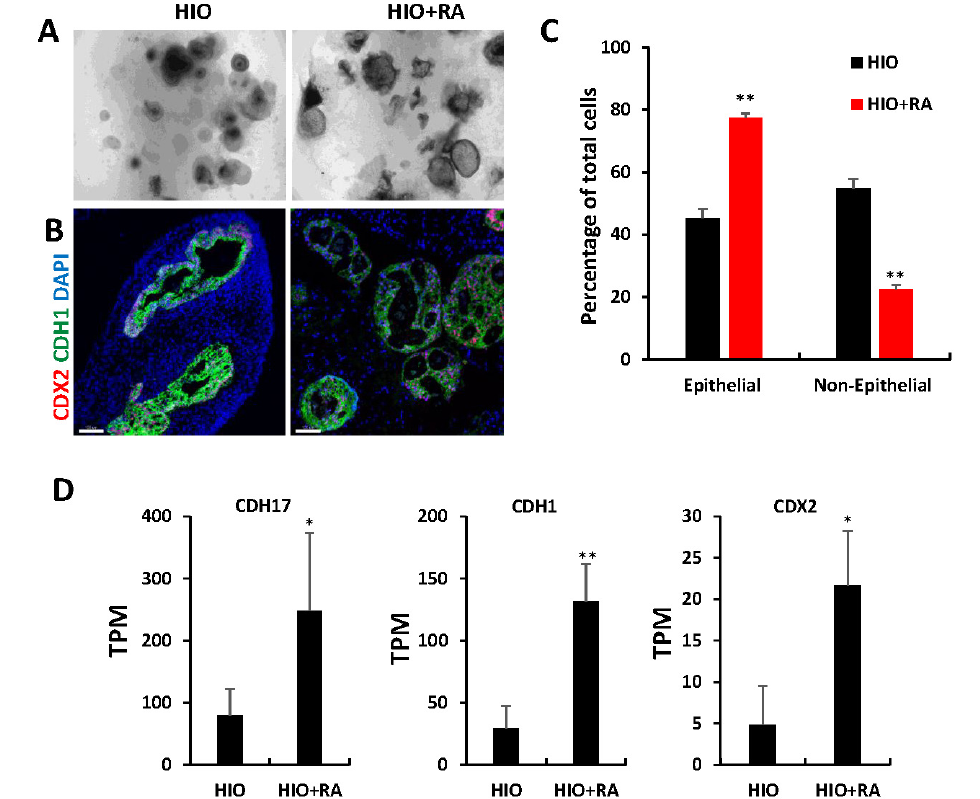
Figure 4. Retinoic acid promotes epithelial growth. ( A ) Light microscopy images of HIOs and HIOs + RA. ( B ) Immunofluorescence staining of 35-day-old organoids from (HIOs and HIOs + RA) for CDX2 (red), CDH1 (green) and counterstained with DAPI. ( C ) Quantification of the percentage of epithelial and non-epithelial cells per organoid section. Data are presented as the mean ± SEM. n = 7–8 organoids per treatment group. ( D ) Graphs of TPM values of epithelial genes from RNA-seq data of 35-day-old HIOs and HIOs + RA. Values are displayed as the mean ± SD. n = 4 per treatment group. * denotes a p value < 0.05. ** denotes a p value of <0.01 based on t